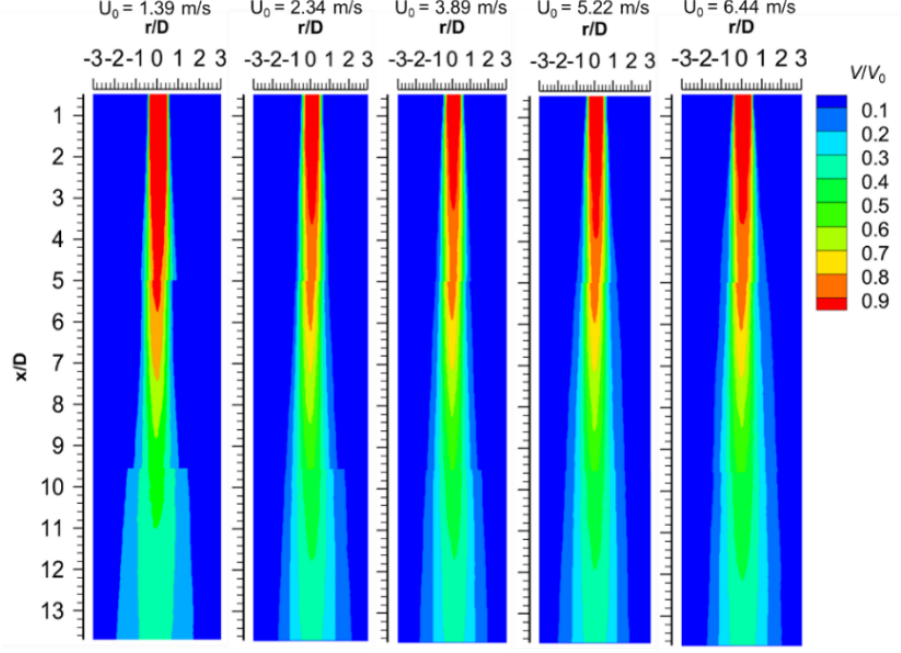
Figure 5. Normalized contour plots of the mean streamwise velocity component.